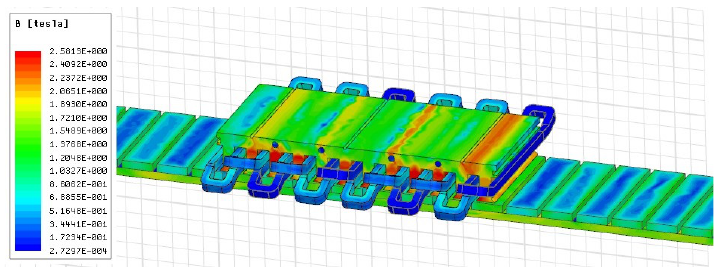
Figure 6. Magnetic field distribution at 0.8 s.